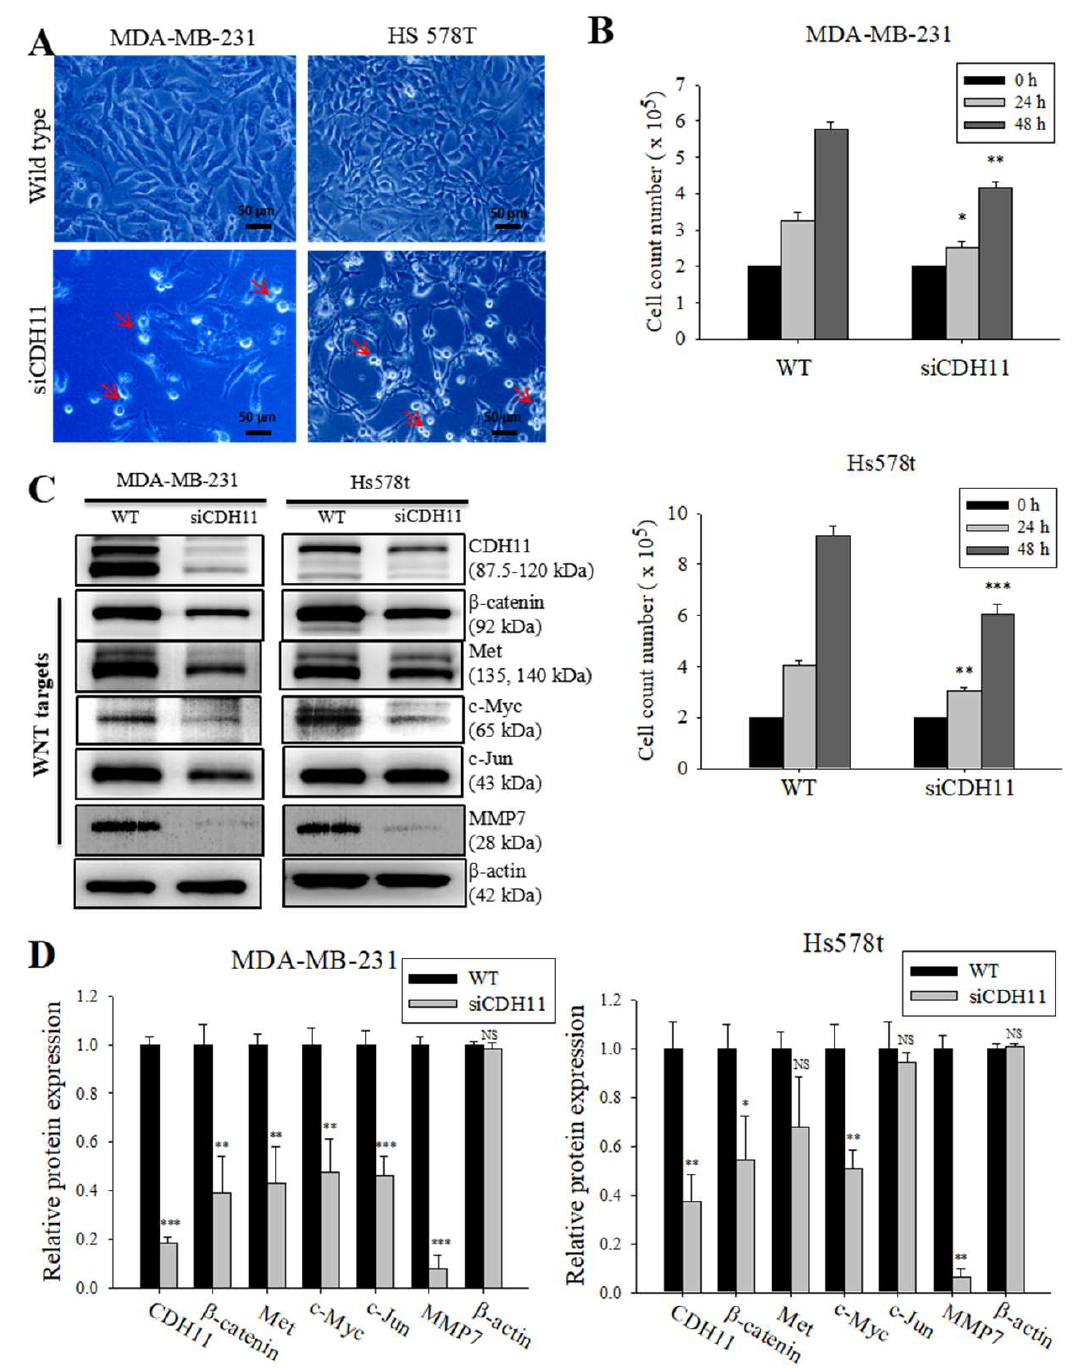
Figure 3. Loss of CDH11 function using siRNA changes cell morphology and inhibits activation of the canonical WNT signalling pathway in TNBC cells. ( A ) The cell morphology of MDA-MB-231 and Hs578t changed from spindle-like to polygonal after loss of CDH11 expression. ( B ) Graphical representation of the effect of siCDH11 on the doubling time of MDA-MB-231 and Hs578t cells as determined by trypan-blue exclusion. ( C ) Western blot results show CDH11 knockdown decreased β -catenin, Met, c-Myc, c-Jun, and MMP7 protein expression level in MDA-MB-231 and Hs578t cell lines. ( D ) Graphical representation of C . Results expressed as mean ± SD of assays done 3 times in triplicate. * p < 0.05, ** p < 0.01, *** p < 0.001; NS, not significant; Red arrow, floating non-viable cells.